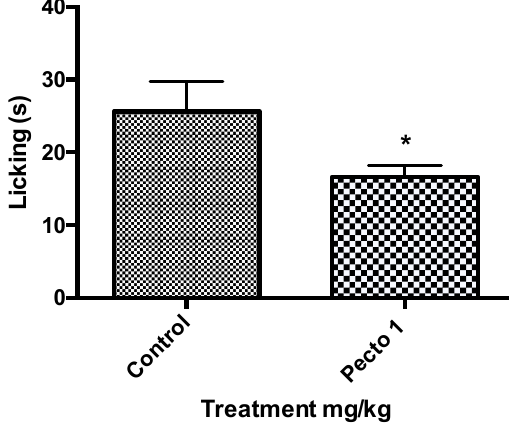
Figure 4. The preliminary results of Pecto 1 (1 mg/kg of pectolinarigenin) using students t-test to analyse the data (* p < 0.05).